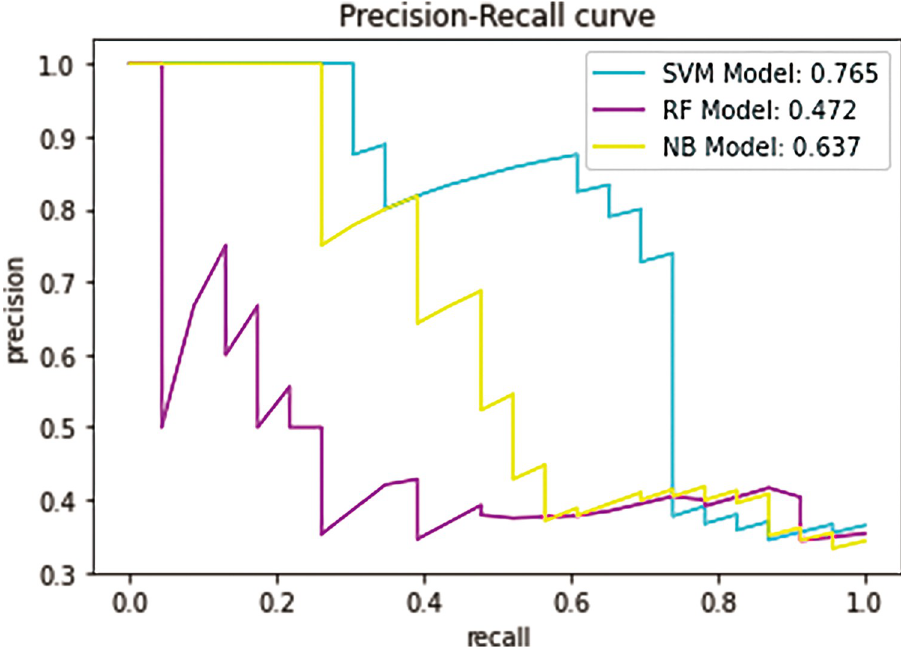
Fig 5. Precision-recall curves of the three candidate models for the prognosis of IgAN.